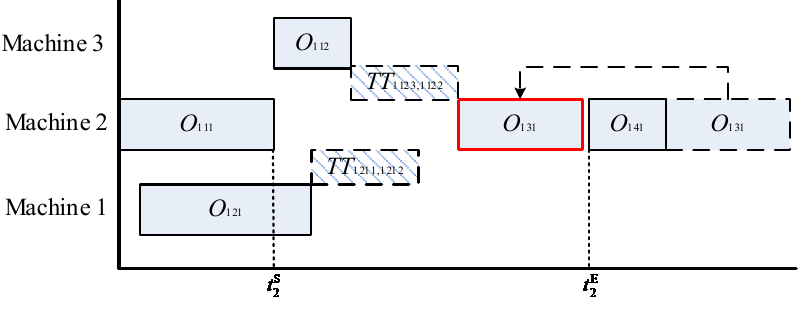
Figure 4. The left-shift process of operation